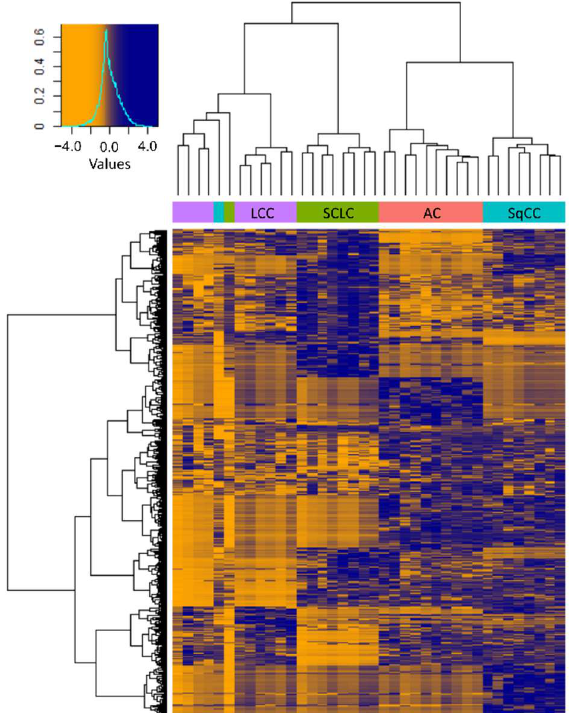
Figure 5. Heatmap with hierarchical clustering of the 571 proteins showing differential expression between the tumorous regions of the 4 LC types investigated (Protein LFQ Intensity values are Z-scored). The histogram in the top left corner shows the correspondence between color hues and values.